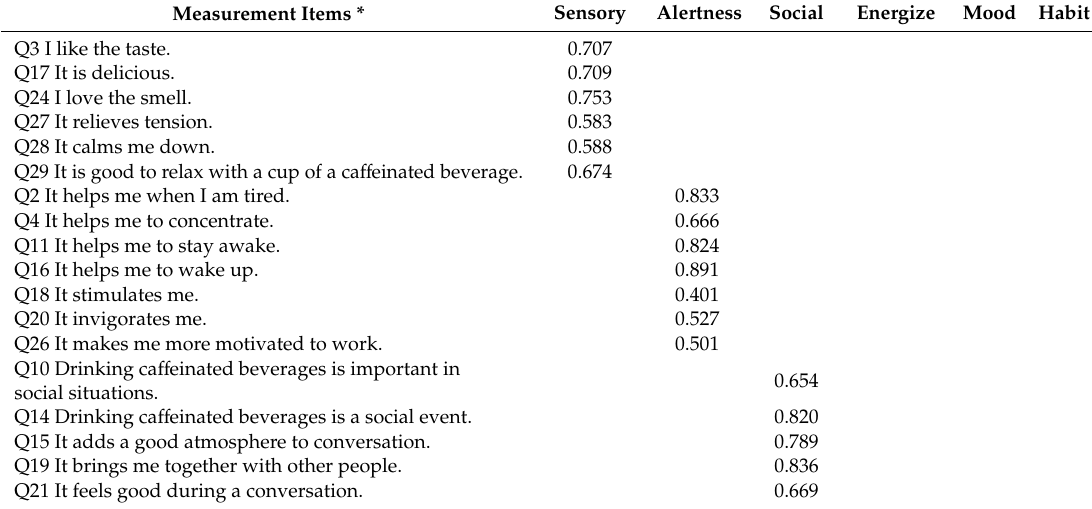
Table 4. Exploratory factor analysis of the motivations for consuming ca ff einated beverages ( n = 381). Measurement Items * Sensory Alertness Social Energize Mood Habit Q3 I like the